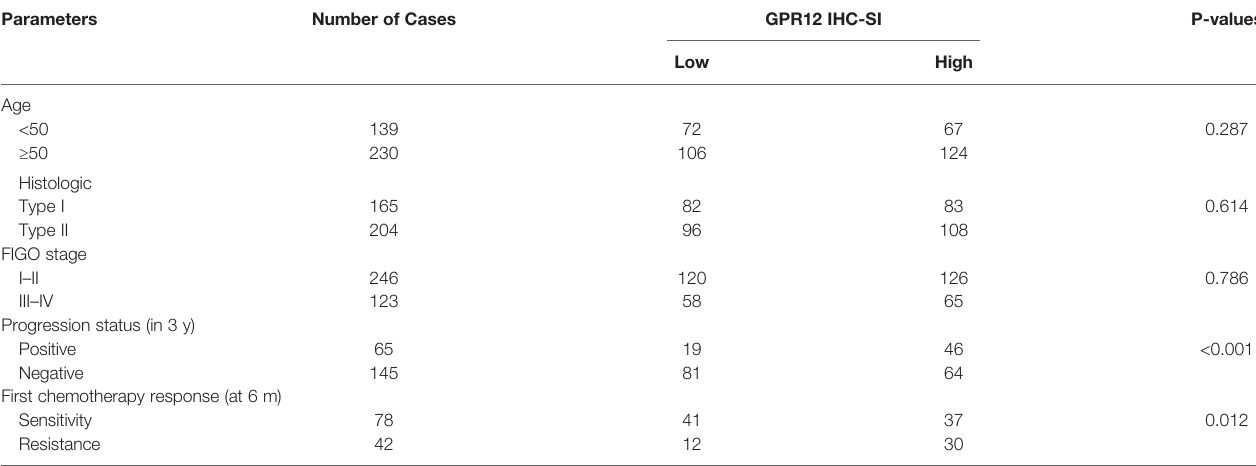
TABLE 1 | The relationship between GPR12 protein level and clinical pathological characteristics in 369 patients with epithelia ovarian cancer.